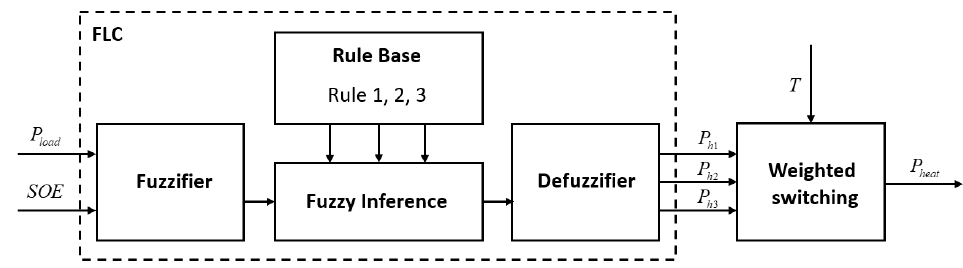
Figure 7. Block diagram of fuzzy logic control of external battery heating.